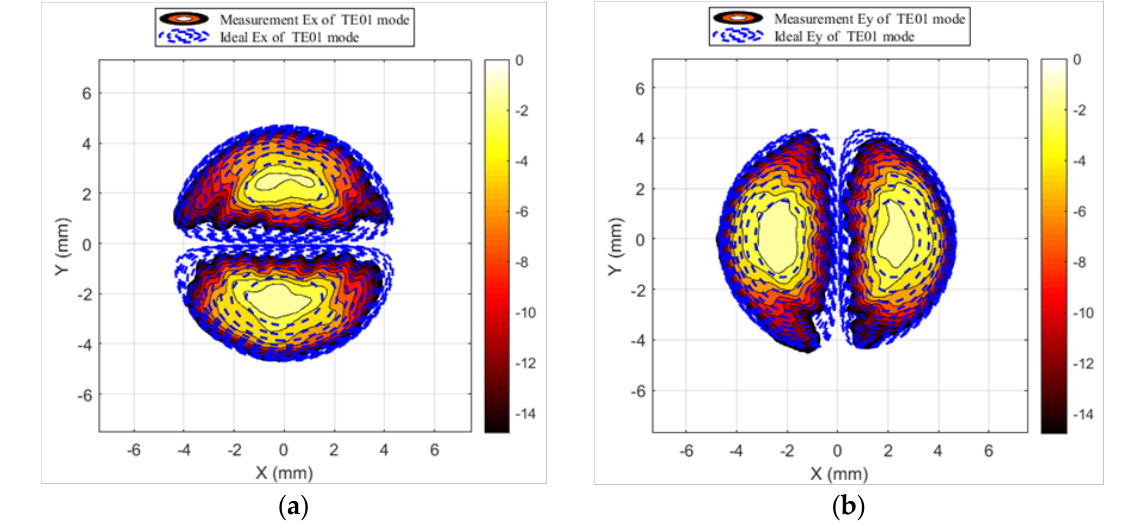
Figure 6. ( a ) The test results of E x of TE 01 mode; ( b ) the test results of E y of TE 01 mode.